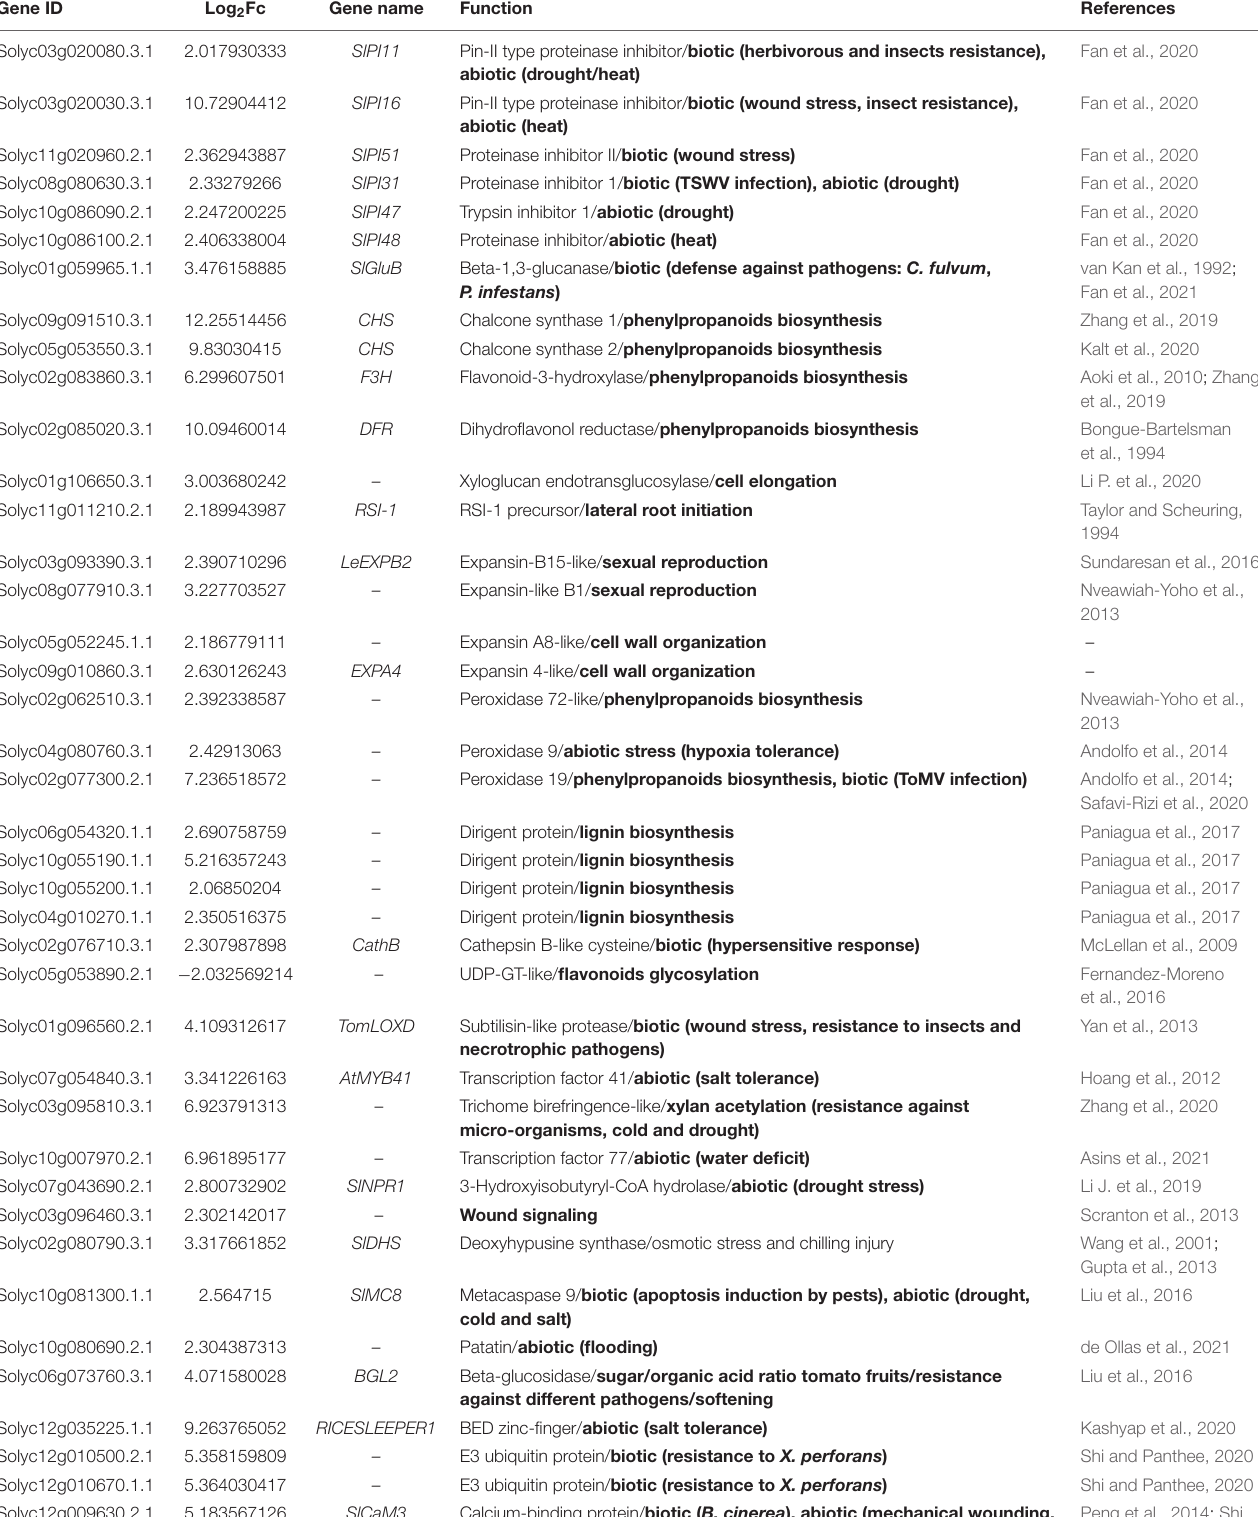
TABLE 1 | List of the more representative and significant DEGs obtained from the GOE and functional annotation analyses in relation to agrospace